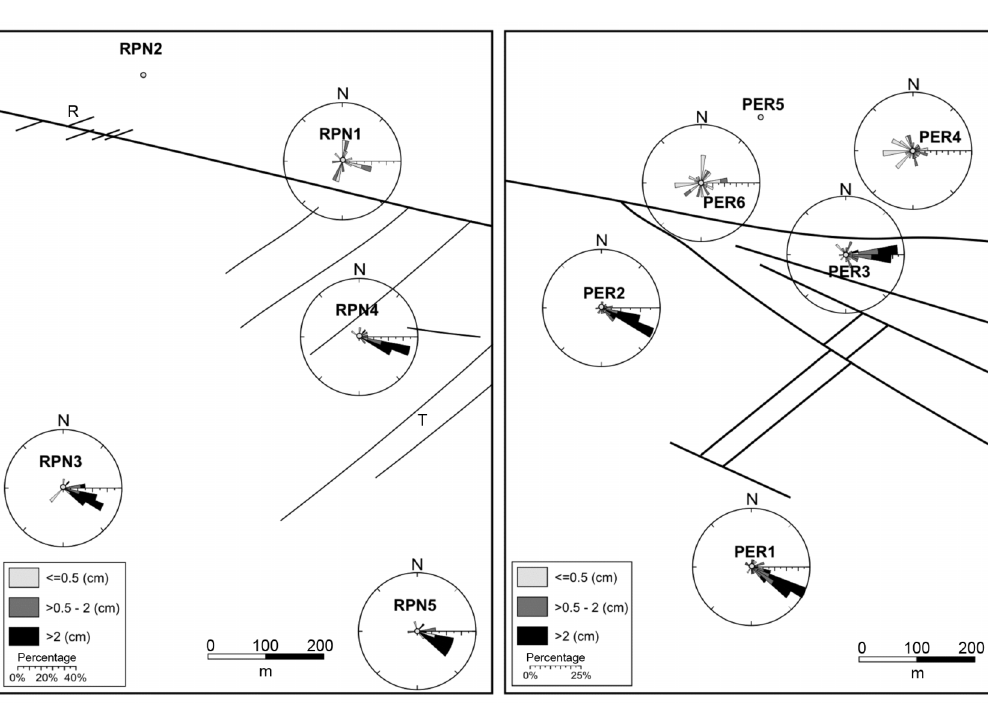
Fig. 4. Wind-rose diagrams relevant to the motion directions for each benchmark. The frequencies of vector di- rections are grouped to 36 direction classes (every 10° of